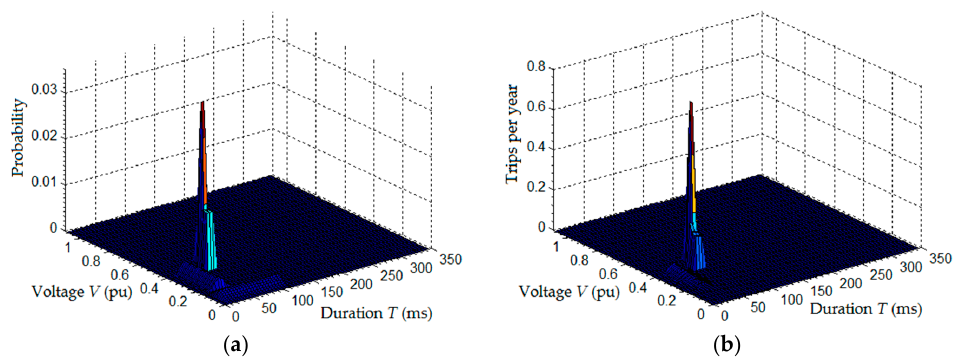
Figure 24. ( a ) Occurrence probability; and ( b ) number of expected equipment trips of various voltage– tolerance curves for contactors considering combination of probability distribution: uniform and/or normal.